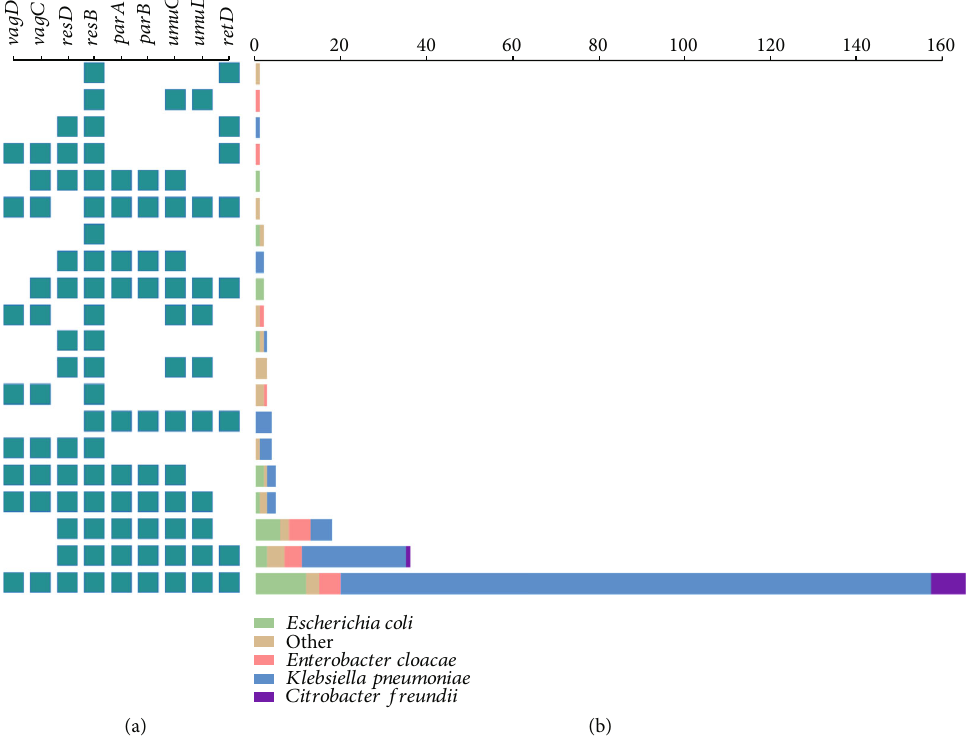
Figure 1: Distribution of plasmids with di ff erent numbers of backbone genes. The small squares on the left represent the presence of corresponding backbone genes. (b) The bars represent the number of plasmids and the corresponding species.